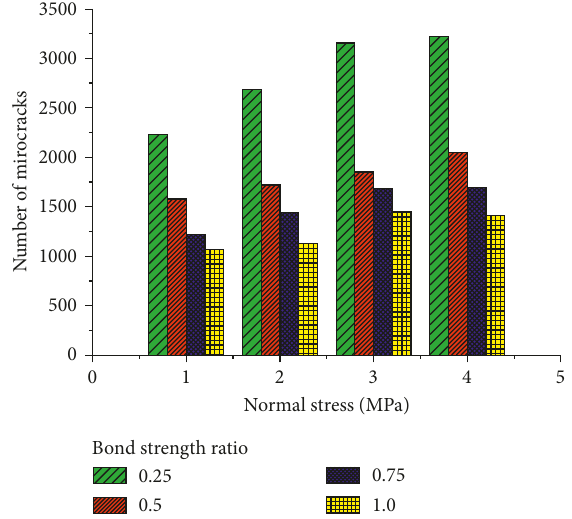
Figure 10: Number of microcracks for specimens with different bond strength ratios under different normal